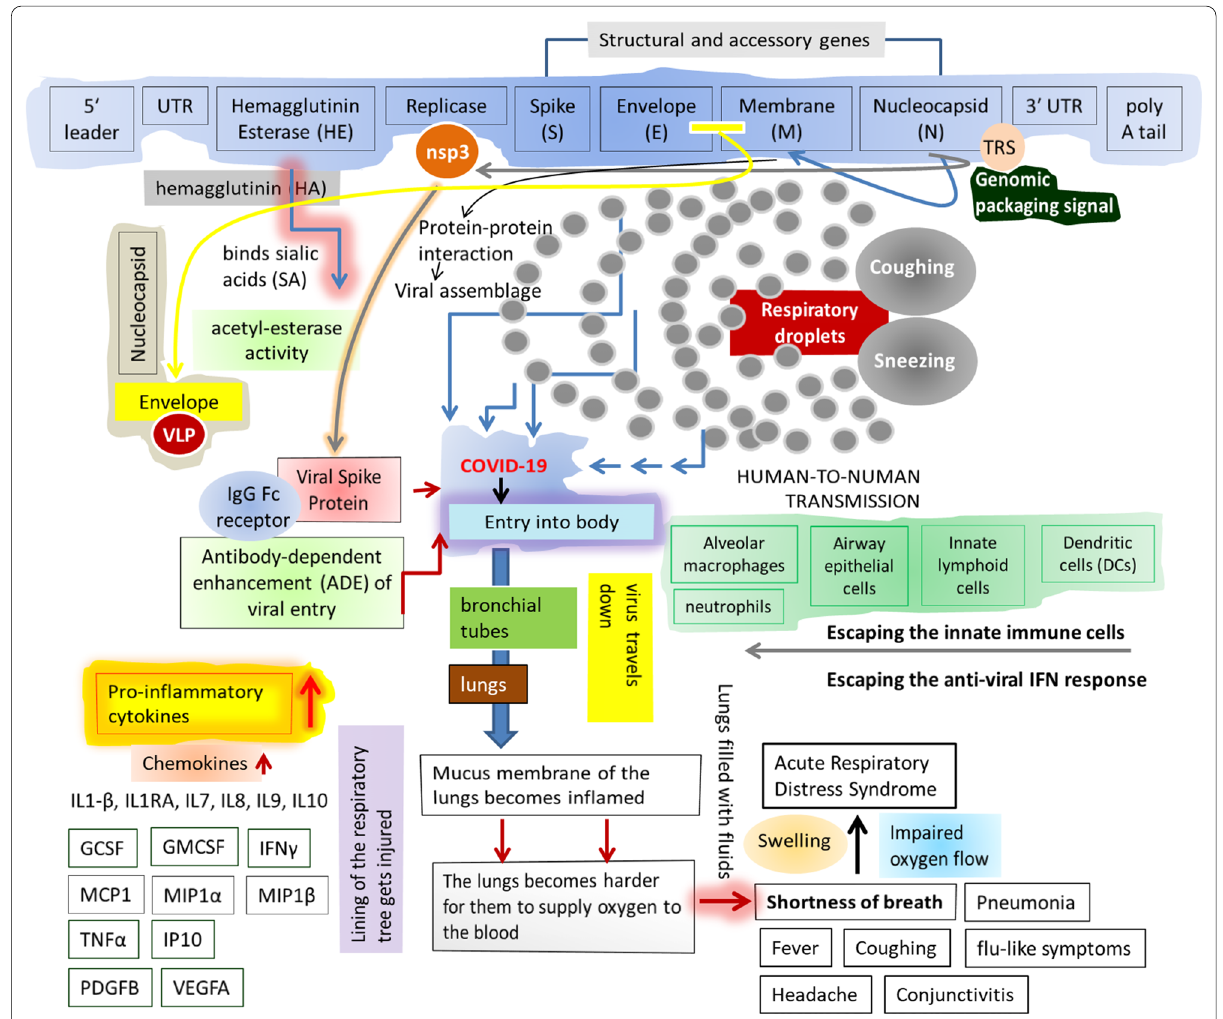
Fig. 1 The RNA genome organization of SARS-CoV-2 is shown to decipher the entry and pathogenesis of the virus. SARS-CoV-2 enters the nasopharyngeal tract through the respiratory droplets ejected from coughing or sneezing by another person(s) in close contact. As shown, the hemagglutinin-esterase (HE) (1) acts as a hemagglutinin (HA), (2) it binds sialic acids (SA) on the surface glycoproteins, and (3) contains acetyl-esterase activity triggering the viral spike (S) protein-mediated host cell entry and subsequent proliferation across the mucosa. The nucleocapsid (N) protein works on two specific RNA substrates: (1) the transcriptional regulatory sequences (TRSs) and (2) the genomic packaging signal. Once inside the host membrane, the virus travels down bronchial tubes to the lungs; and as a result, the lining of the respiratory tree becomes injured which in turn irritates the nerves of the lining of the airway; and the resultant impact is the inflammation and hardening of the mucus membrane of the lungs making difficult to supply oxygen to the blood instigating the increased shortness of breath. The significant increase in the pro-inflammatory cytokines and chemokines (including IL2, IL7, IL10, GCSF, IP10, MCP1, MIP1α, and TNFα), i.e., the cytokine storm has been shown to induce the local inflammation generating the severe onset of the